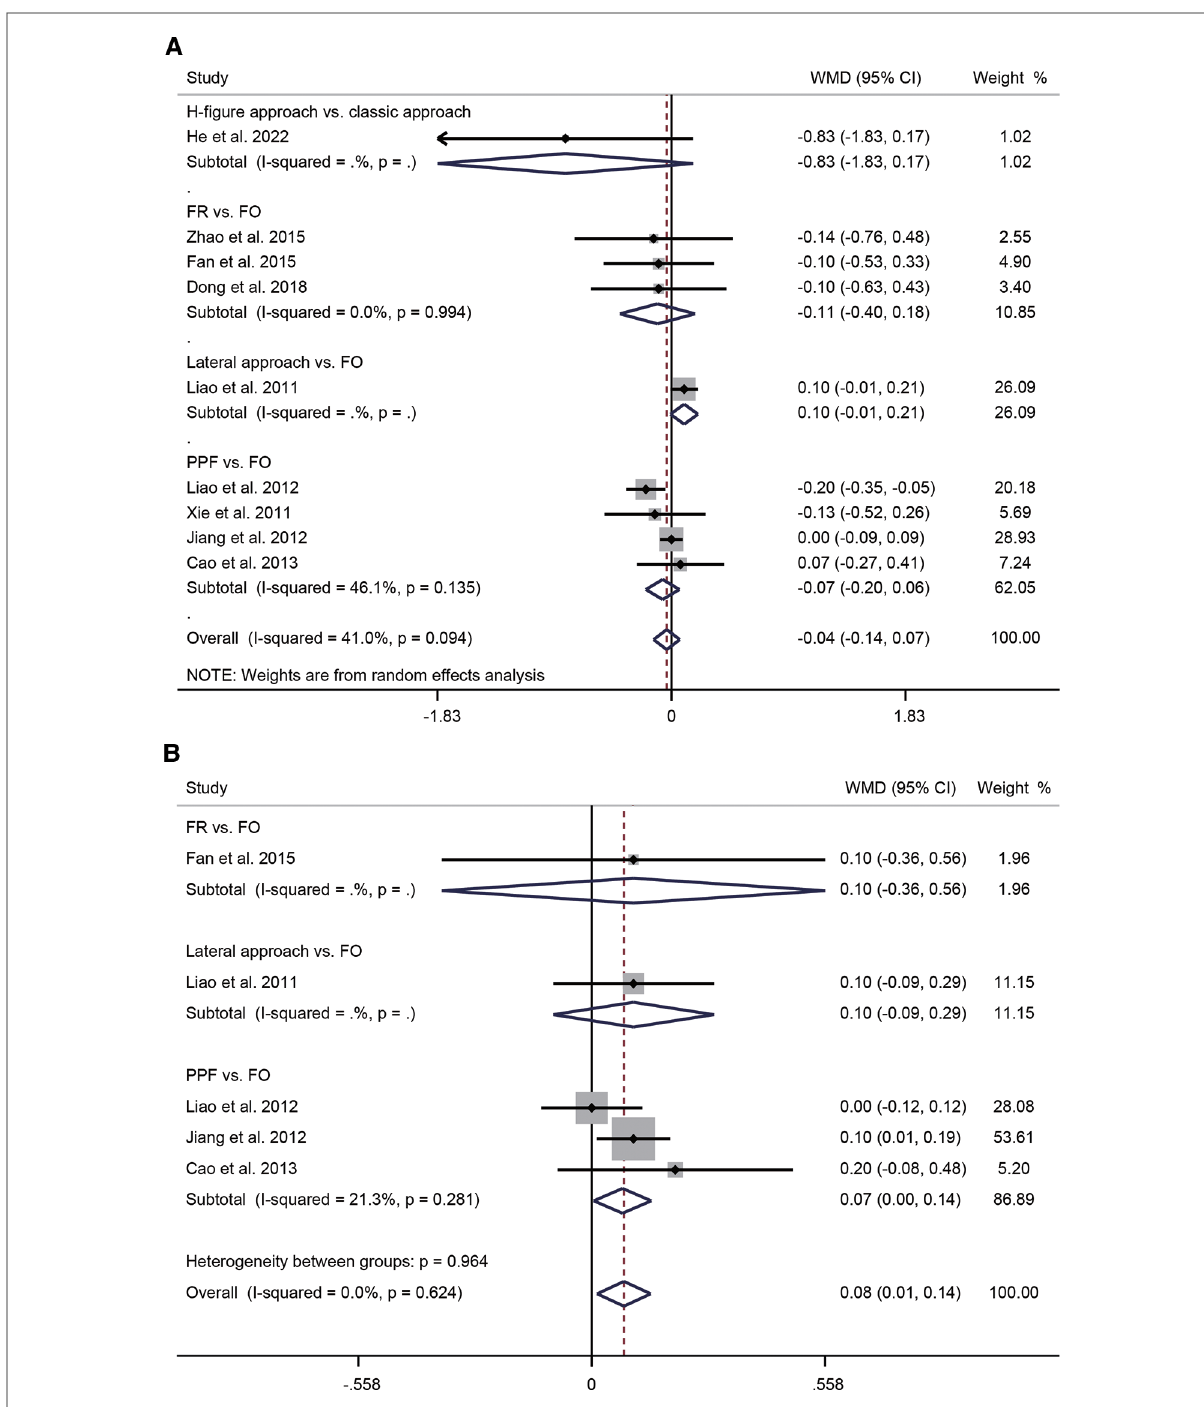
FIGURE 2 Forest plot of VAS at 6 months ( A ) and VAS at 12 months postoperatively ( B ) for the comparison of different puncture approaches (other puncture approaches vs. FO). VAS, visual analog scale; FO, foramen